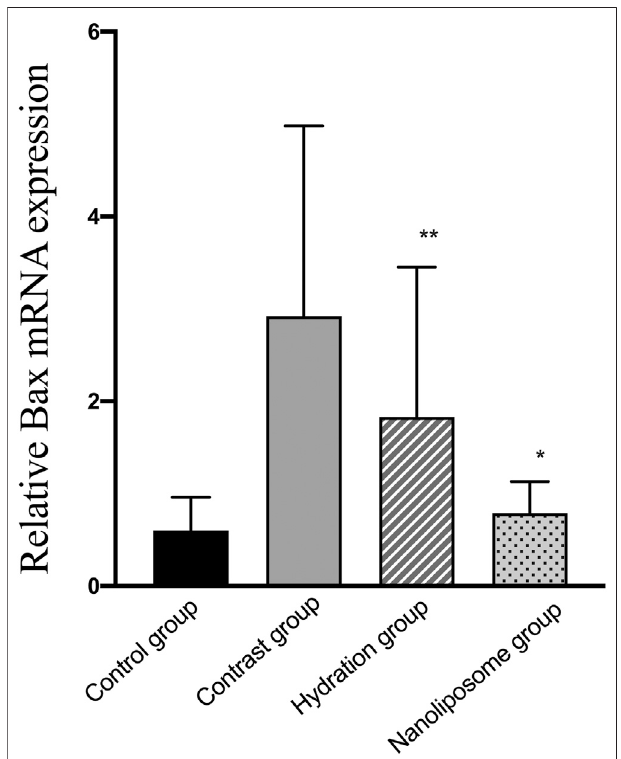
FIGURE 7 | Quantitative comparison of CIN incidence in four groups. CIN (cid:2) Contrast Induced Nephropathy. Values are expressed as mean ± SD. *Compared with the contrast group, p < 0.05. **Compared with the contrast group, p < 0.01. # Compared with the hydration group, p < 0.05. ## Compared with the hydration group, p < 0.01.